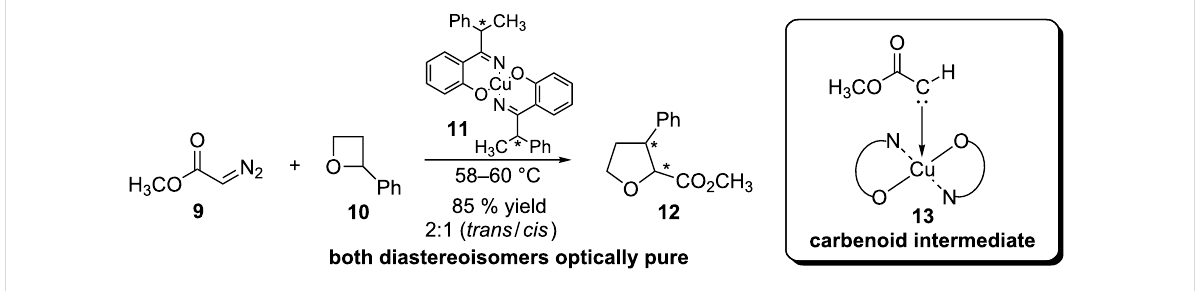
Table 1: Enantioselective insertion of α -diazo- β -ketoesters into C(sp 3 )–H bonds catalyzed by chiral rhodium(II) complexes 17a , 17b and 17c .